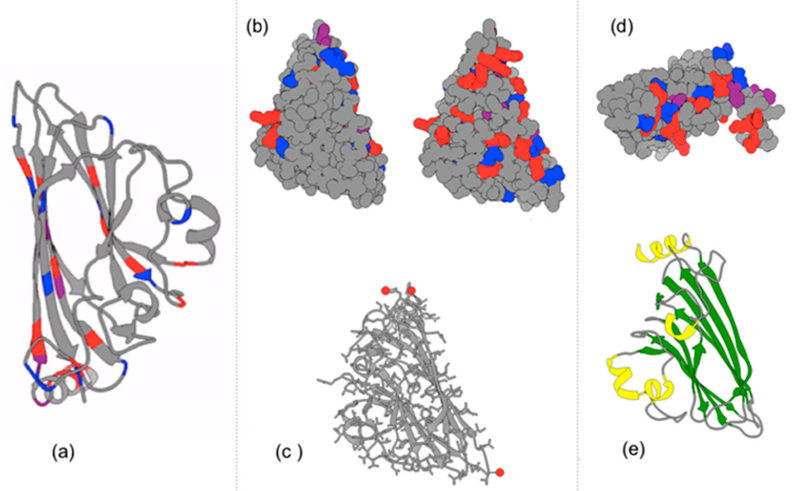
Figure 8. The T1 Satellite Tobacco Necrosis Virus capsomeres are illustrated with Chimera software [insert # reference] using the 3D X-ray crystallography data from the PDB: ( a ) Ribbon structure of beta-pleated sheets and alpha-helices; Positively charges residues are colored red. Negatively charged residues are colored blue. ( b ) Charged residues are highlighted on two different 3D rota- tions of a capsomere; The front (left) and back (right) of the monomeric subunit. Note the abundance of charged amino acids on the inside of the capsomere, as well as on the sides where capsomeres contact one another. ( c ) Calcium ions are associated with two of the three vertices of the triangular capsid. Calcium ions interact with Asp, Glu, and Thr residues. These are more visible when exam- ining multiple subunits. ( d ) Interestingly, positively charged alpha helices of the capsomeres extend into the interior of the polyhedral capsid which can bind with the negatively charged phosphates in the nucleic acid (RNA) genome in the interior of the capsid; ( e ) Ribbon secondary structure of a capsomere where an alpha-helix (yellow) extends orthogonally with respect to the primary axis of the capsomere’s surface. Note that two large Beta-pleated sheets (green) on the right are antiparallel to one another. First, we [27] constructed a self-assembling icosahedron (Figure 9; Supplemental Movie S1). We use a Schlegel diagram (Figure 10) to construct a topological model of where to place the magnets so that all identical subunits align and bind. As was previously done with Olson’s dodecahedron model [22,24–26], by reversing the location of north and south poles of all of our magnets, we can construct two different enantiomers of the self- assembling icosahedron. See Tibbits [11] (pp. 80–82) for a similar experiment with two different enantiomers of the self-assembling dodecahedron.